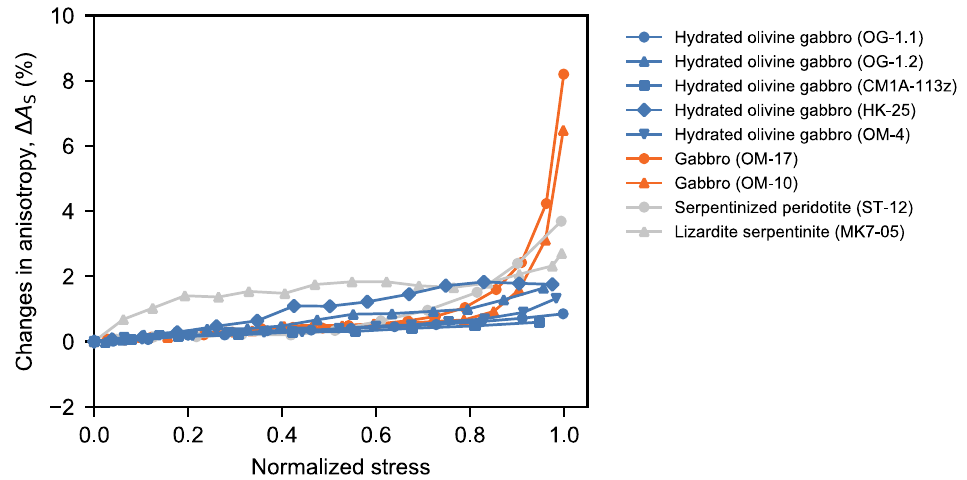
Figure 6. Relative changes in S-wave anisotropy during deformation experiments. Differential stress is normalized by the maximum differential stress in each sample. S-wave anisotropy was calculated as A S = ( V SV − V SH ) / V S × 100, where V S = ( V SV + V SH ) /2 [33].